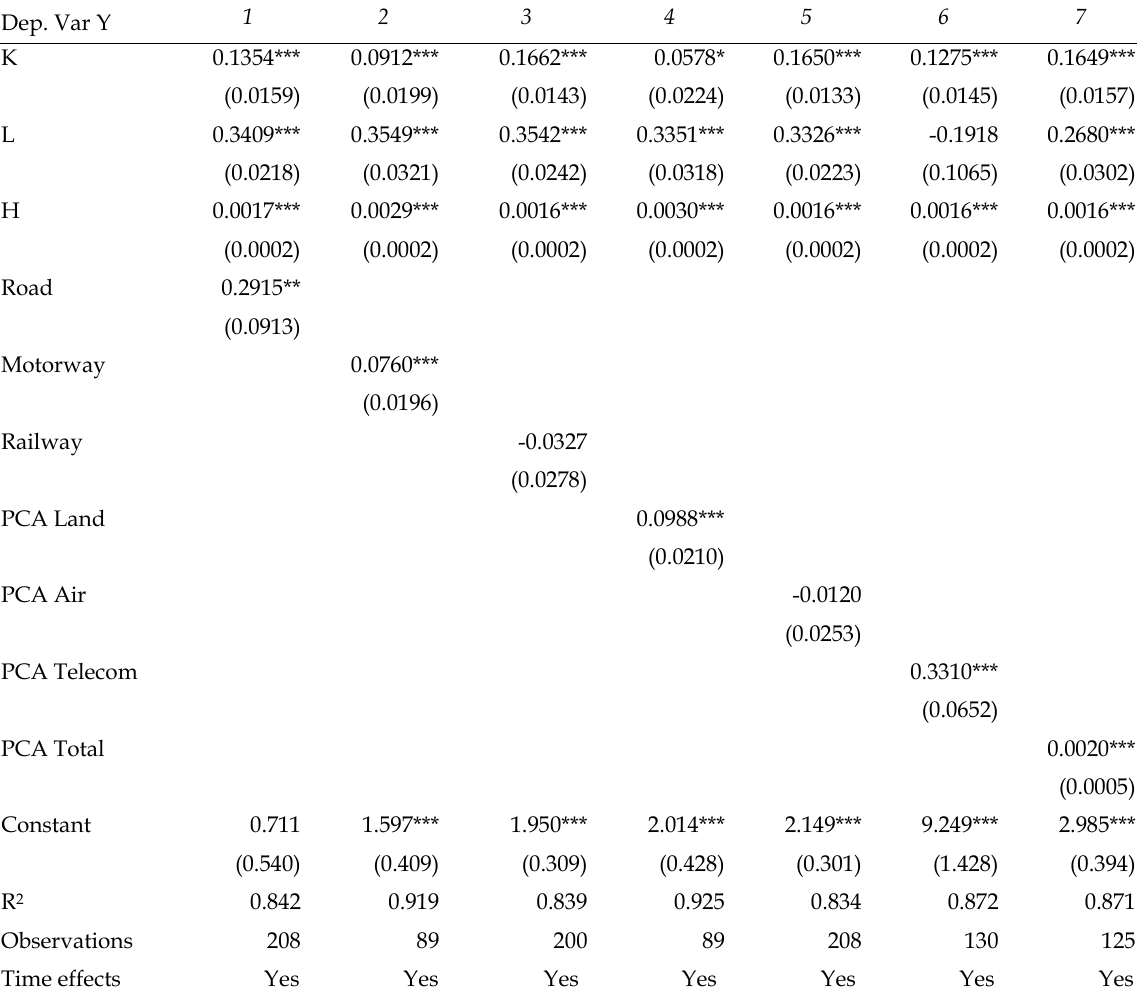
Table 4. Results of the OLS estimation Dep. Var